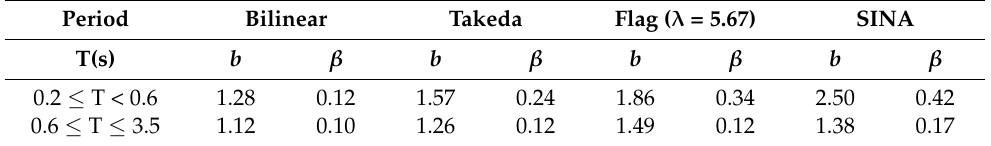
Table 2. Generalization of the proposed ‘b’ value to short and medium period ranges. Period Bilinear Takeda Flag ( λ = 5.67) SINA T(s) b β b β b β b β 0.2 ≤ T <